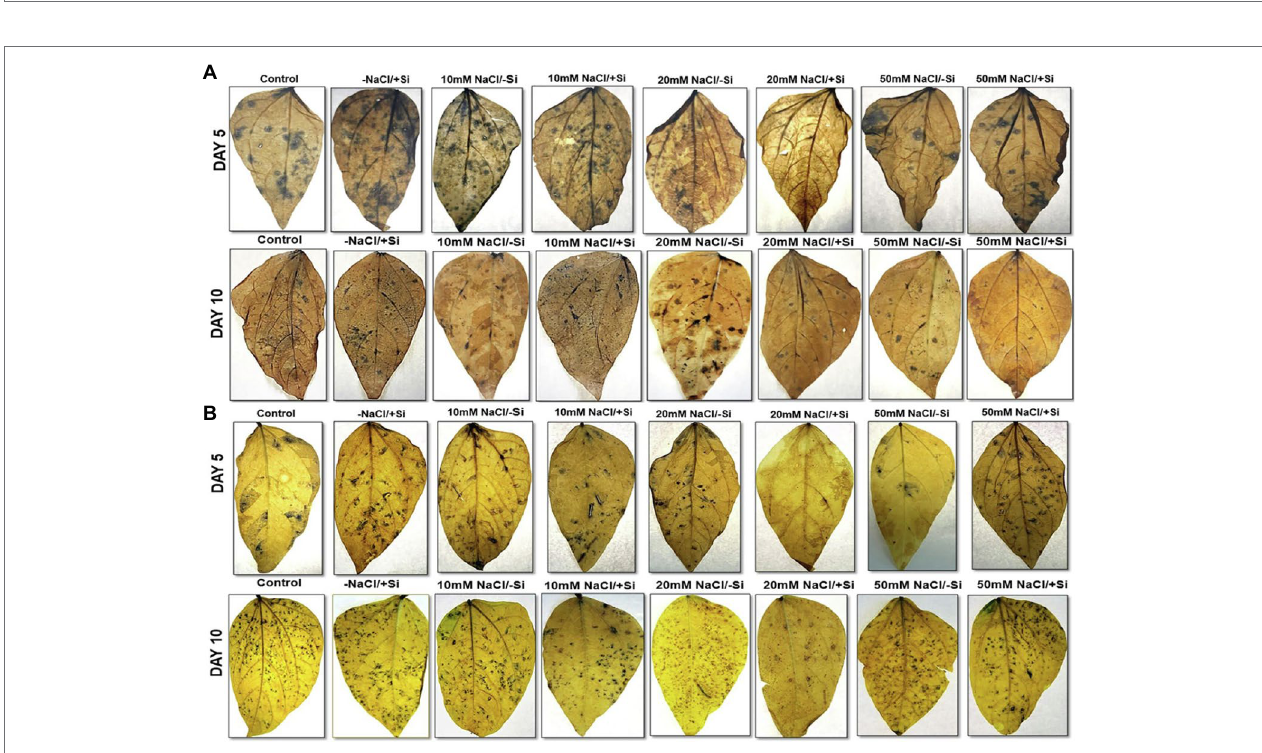
FIGURE 12 | Histochemical localization of O 2 − in mung bean ( Vigna radiata ) under (A) 1 mM (Si 1 ) and (B) 5 mM (Si 2 ) Si supply and salinity stress after eight treatments: (i) control (T1), (ii) − NaCl+Si (1 mM/5 mM) (T2), (iii) 10 mM NaCl/ − Si (T3), (iv) 10 mM NaCl/+Si (1 mM/5 mM) (T4), (v) 20 mM NaCl/ − Si (T5), (vi) 20 mM NaCl/+Si (1 mM/5 mM) (T6), (vii) 50 mM NaCl/ − Si (T7), and (viii) 50 mM NaCl/+Si (1 mM/5 mM) (T8) for a period of 5 and 10 days.